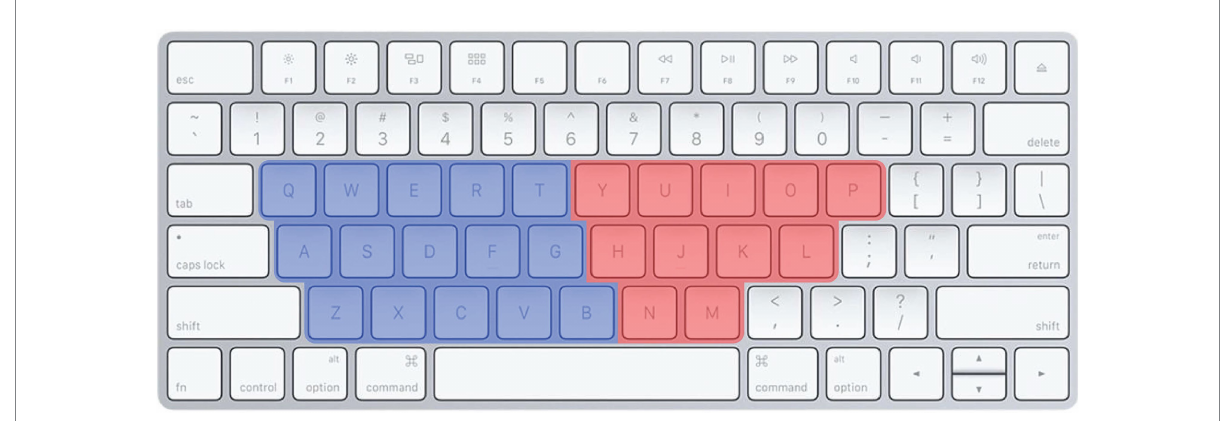
FIGURE 1 On the QWERTY keyboard, some letters are typed with the left hand (blue) and some are typed with the right hand (red). The left–right distribution of letters on this interface influences the meaning of words as predicted by the GOOD IS RIGHT metaphor. Image by Fletcher, distributed under a CC-BY 4.0